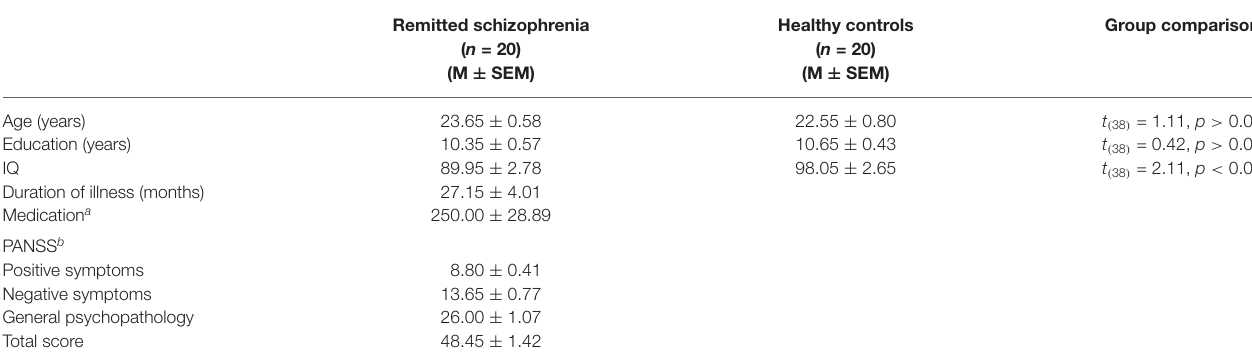
TABLE 1 | Demographic and clinical characteristics of the study